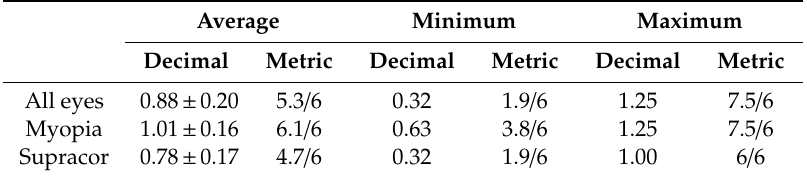
Table 1. Uncorrected visual acuity after regular myopia and Supracor presbyopia treatment.